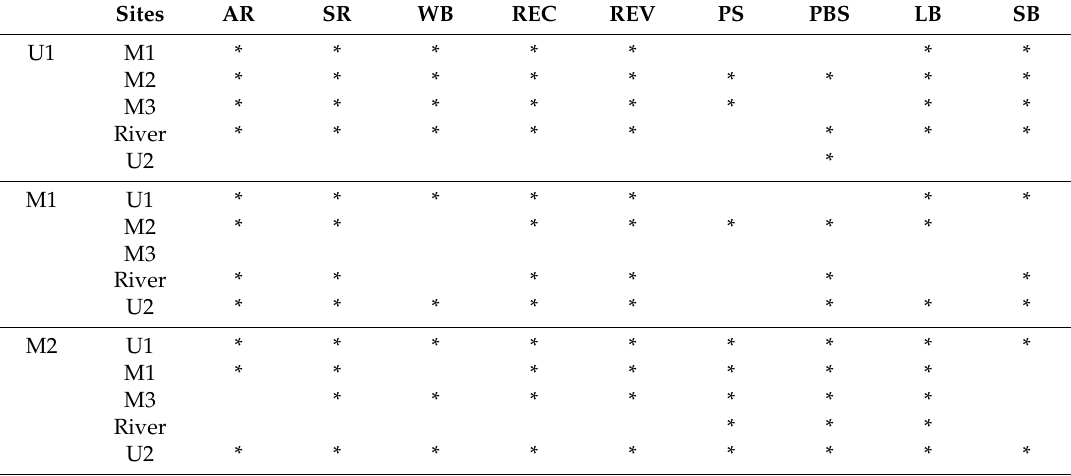
Table 6. Study sites differences between perceptions of health effects and landscape using Bonferroni post-hoc tests ( N =